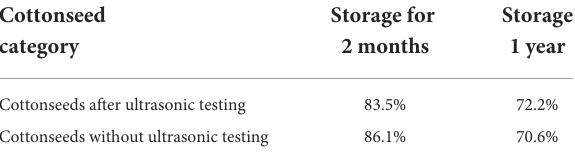
TABLE 1 The results of cottonseeds germination